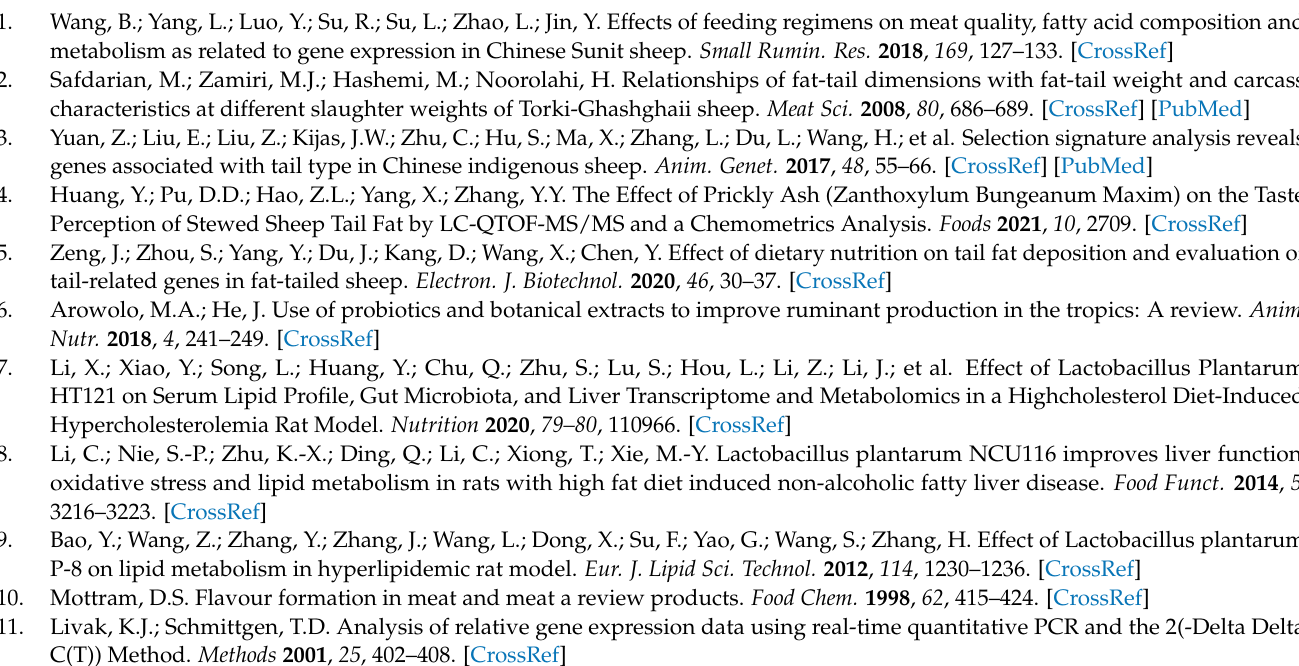
pathways with different color dots representing the differential compounds; Figure S4: “oas01100”. Metabolic pathways with different color dots representing the differential compounds in the two comparison groups; Figure S5: “oas01040”, biosynthesis of unsaturated fatty acids. Red means upregulation; blue means downregulation; Table S1: Primer sequences for real-time PCR assays; Table S2: Sunit sheep crude tail fat